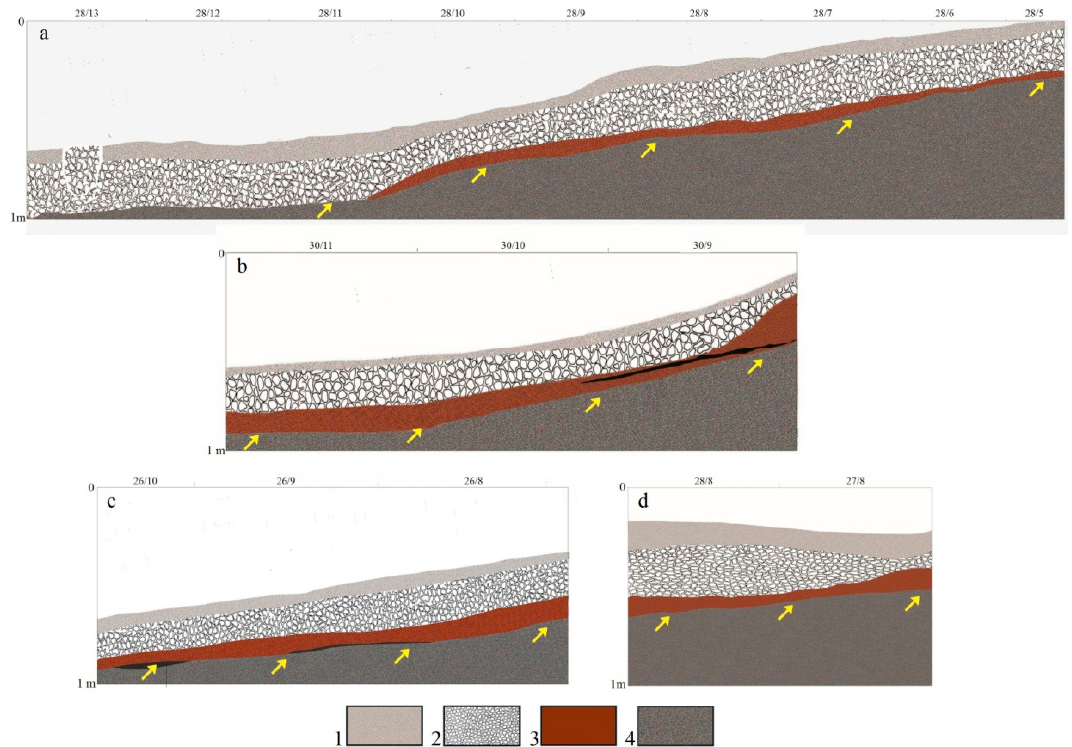
Figure 7. Examples of stratigraphic sections from the excavations of CM. ( a – c ) East / west direction, ( d ) north / south direction. References: 0 = Datum, the numbers in the upper part of the datum indicate the grids; the rectangles at the bottom show the layers. The black lenses in ( b , c ) are carbonized sand and a hearth, respectively. The arrows indicate the position of the PA archaeological level at the top of layer four.